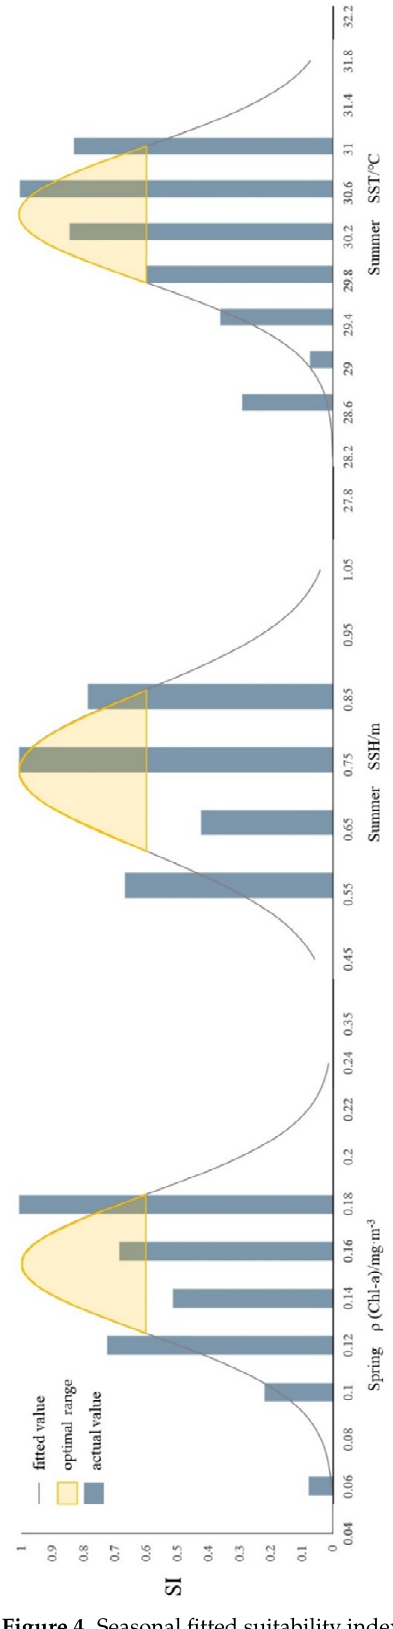
Figure 4. Seasonal fitted suitability index (SI) curves inferred from associations between fishing effort and Chlorophyll-a (Chl-a) concentration, sea surface height (SSH), and sea surface temperature (SST), spring to summer, 2015–2019.